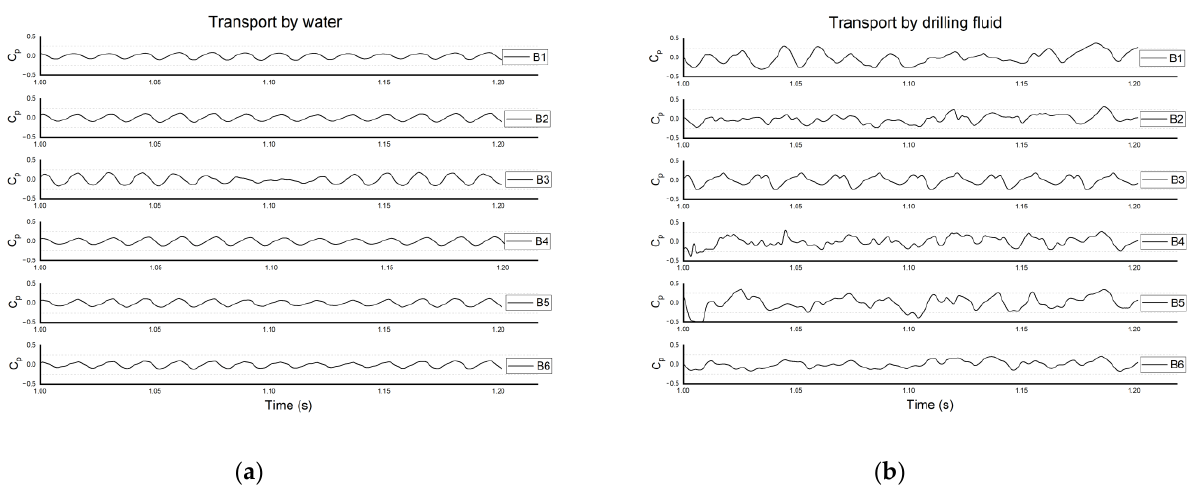
Figure 10. Pressure coefficients at the different points on blade surface (B1 – B6). ( a ) Water case; ( b ) drilling-fluid case.